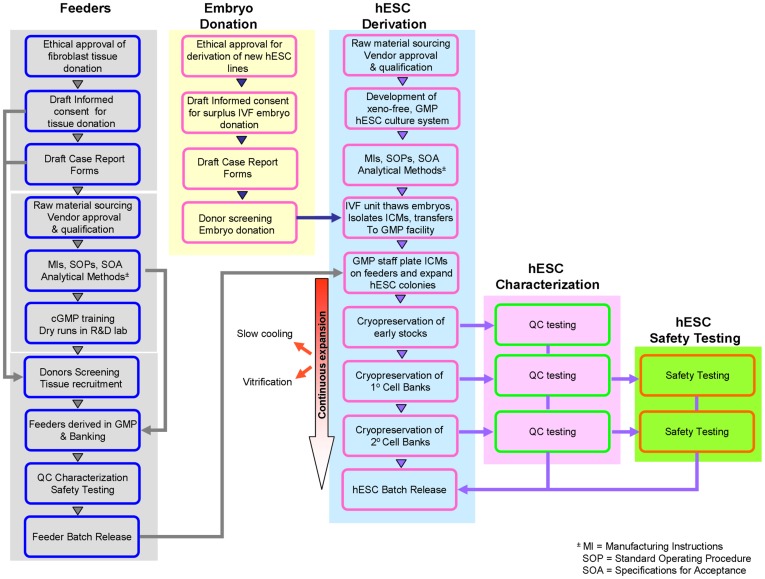
Process flow diagram of the approach taken in deriving xeno-free clinical-grade fibroblast feeders and hESCs.The scheme indicates the ethical, scientific, and regulatory steps taken in deriving our clinical-grade fibroblast feeders and hESCs.